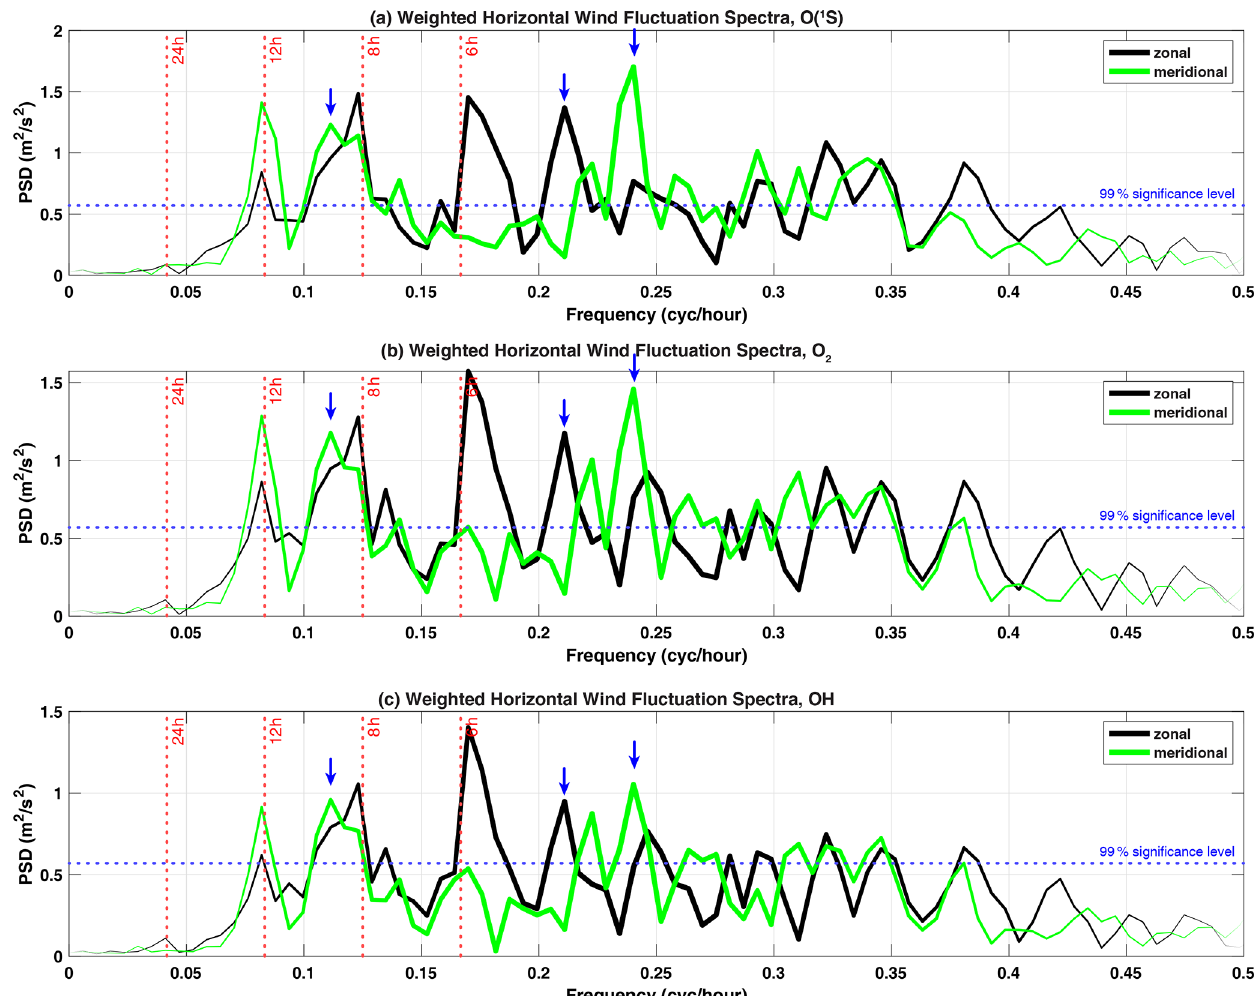
Figure 7. Spectra of weighted zonal and meridional wind fluctuation of Fig. 6. The dashed red lines indicate tidal periods. The vertical blue arrows indicate wave frequencies of persisting wave structures also seen in the airglow brightness. Statistical 99% significance level is indicated by dotted blue